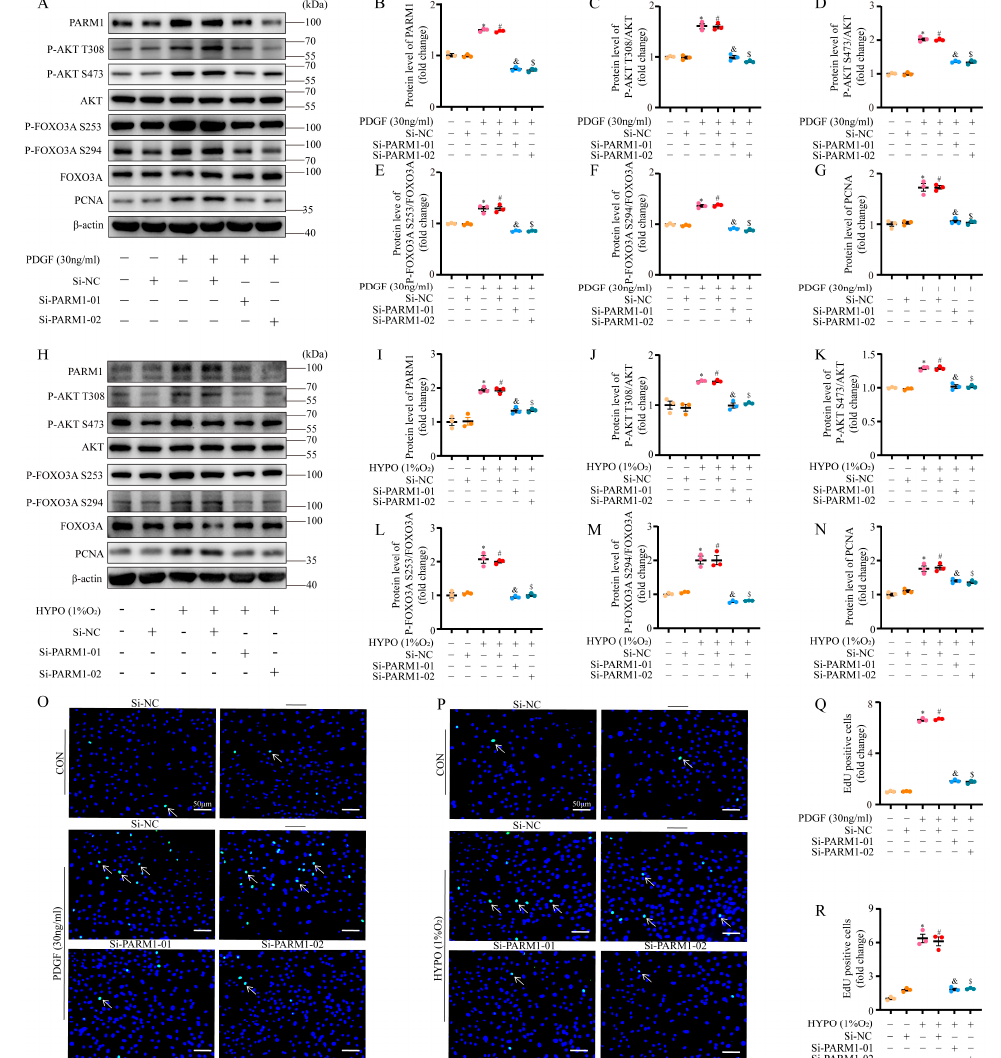
Figure 8. PARM1 siRNA exhibited the anti-proliferation effects in PDGF/hypoxia-treated PASMCs. ( A – G ) Representative Western blots and quantification of PARM1, p-AKT(T308), p-AKT(S473), AKT, p-FOXO3A(S253), p-FOXO3A(S294), FOXO3A, and PCNA in cultured PASMCs under control or PDGF (30 ng/mL) conditions, plus treatment with si-RNA targeting PARM1 (si-PARM1) or negative control siRNA (si-NC). Equal protein loading was con fi rmed using an anti- β -actin antibody. ( H – N ) Representative Western blots and quanti fi cation of PARM1, p-AKT(T308), p-AKT(S473), AKT, p-FOXO3A(S253), p-FOXO3A(S294), FOXO3A, and PCNA in cultured PASMCs under control or hypoxia (1% O 2 ) conditions, plus treatment with si-PARM1 or si-NC. Equal protein loading was con fi rmed using an anti- β -actin antibody. ( O , Q ) Representative EdU incorporation assay and quanti fi cation of the ratio of PASMCs incorporated with EdU under the control or PDGF (30 ng/mL) condition plus treatment with si-PARM1 or si-NC, in which nuclei stained with 1 X Hoechst 33342 (blue) and incorporated EdU merged with 1× Hoechst 33342 are shown in green (n = 3 random microscopic visions; Scale bar, 50 µm). ( P , R ) Representative EdU incorporation assay and quantification of the ratio of PASMCs incorporated with EdU under the control or hypoxia (1% O 2 ) conditions, plus treatment with si-PARM1 or si-NC, in which nuclei stained with 1 × Hoechst 33342 (blue) and incorporated EdU merged with 1 × Hoechst 33342 are shown in green (n = 3 random microscopic visions; Scale bar, 50 µ m). Data are shown as mean ± SEM; * p < 0.05 vs. CON group; # p < 0.05 vs. the CON + SiNC group; & p < 0.05 vs. the HYPO/PDGF + SiNC group; $ p < 0.05 vs. the HYPO/PDGF + SiNC group (student’s t -test). HYPO, hypoxia; PDGF,